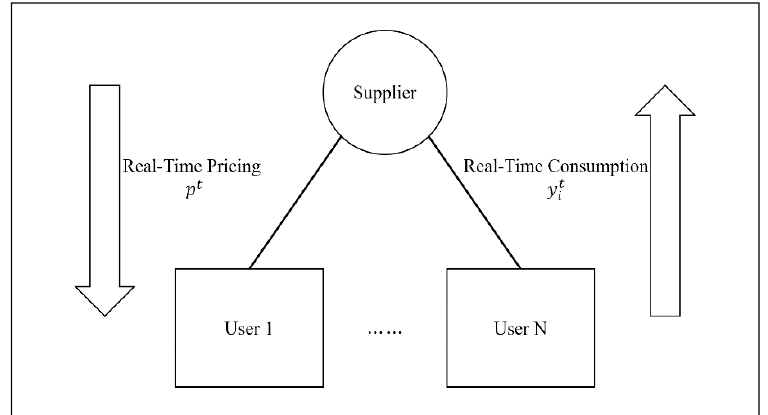
Figure 1. Structure of the Stackelberg game.